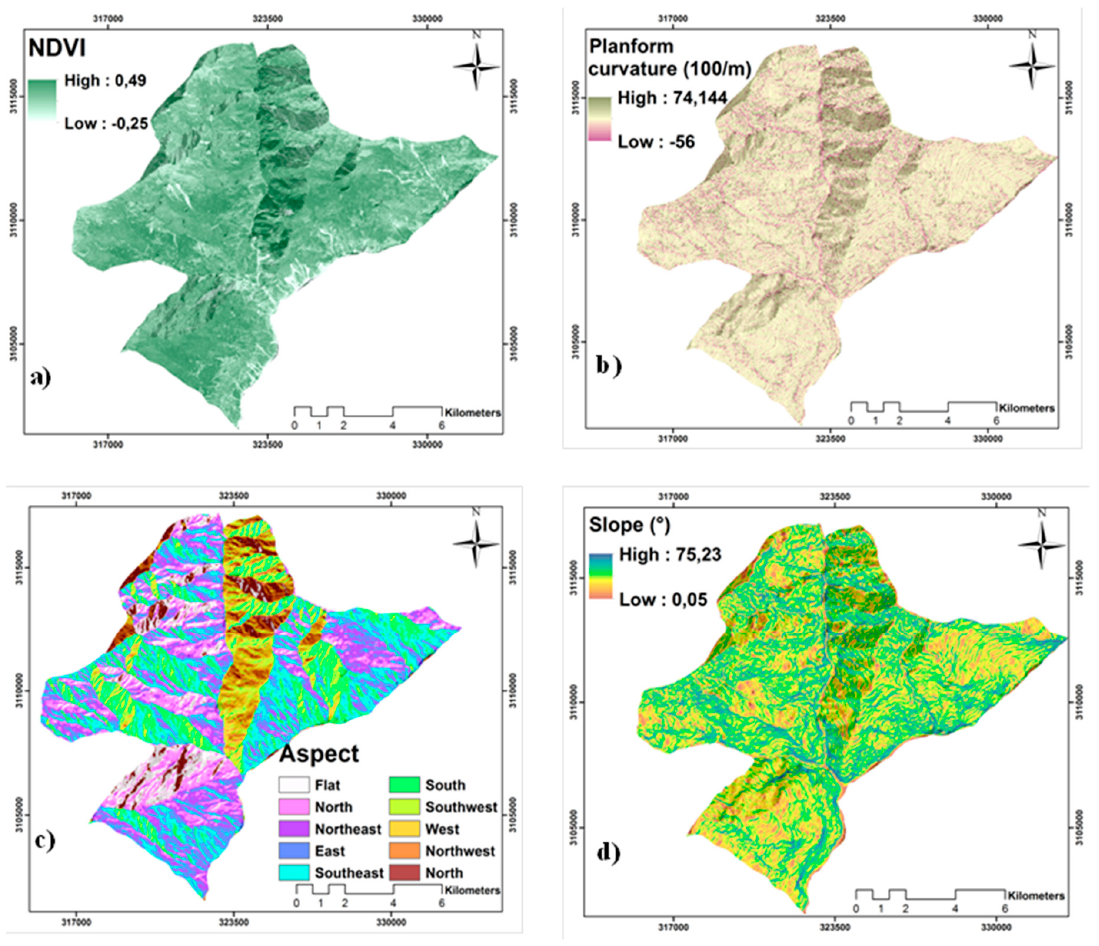
Figure 2. ( a ) NDVI and the produced topographic factors ( b ) slope, ( c ) aspect and ( d ) plan curvature.